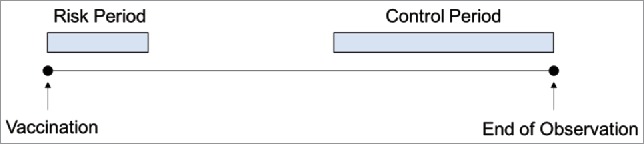
Self-Controlled Case-Series Design. The observation period for each patient begins with vaccination. The risk period denotes a time when the likelihood of an outcome (ED visit, or hospital admission) related to the vaccination is most likely. The control period captures a window of time when the likelihood of an outcome related to vaccination is unlikely. The intervening days represent a ‘wash-out’ period.